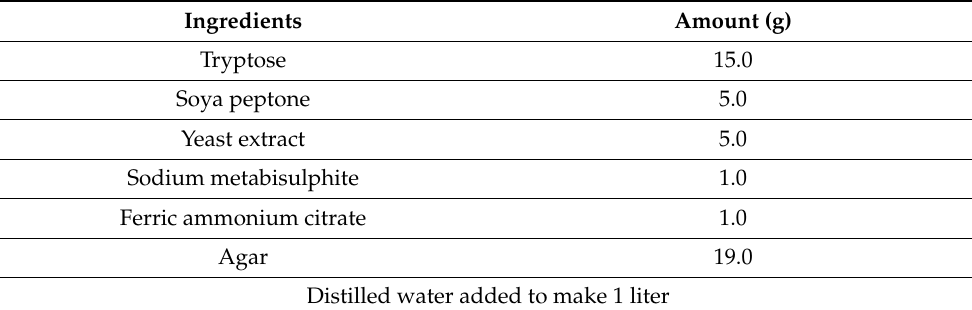
Table 2. Composition of Perfringens agar.